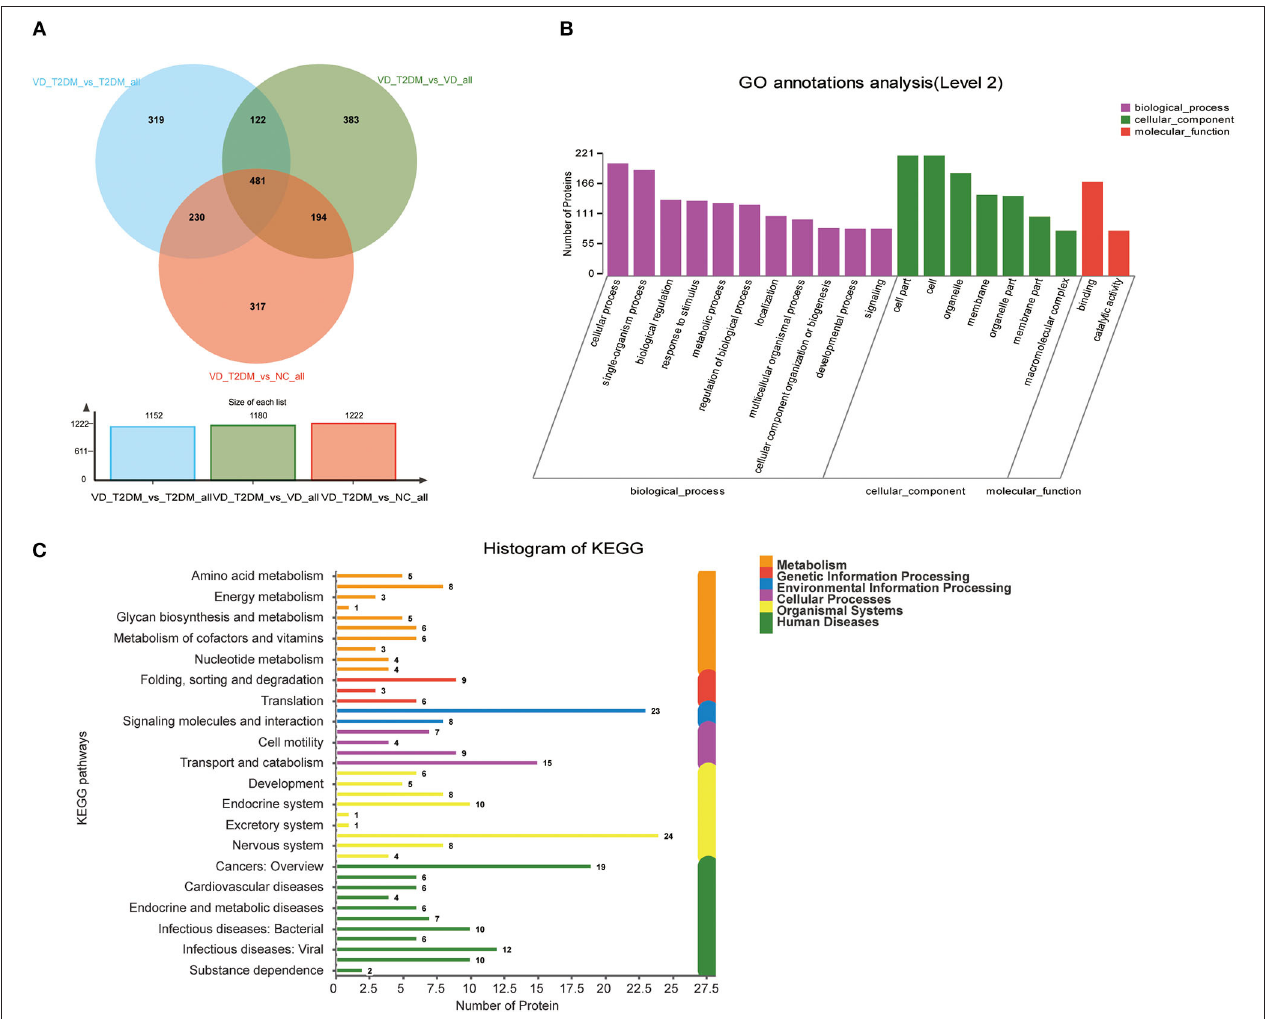
FIGURE 6 | Volcano plots of quantified proteins and functional analysis of DEPs in urine between the VD + T2DM group and the other three groups. (A) Venn chart of urine-based proteome analysis identified from the VD + T2DM group vs. the other three groups. (B) GO enrichment analysis of differential urine-excretory proteins. Purple bars denote the enriched biological processes, green bars denote enriched cellular components, and red bars denote enriched molecular functions. Protein numbers enriched in each category are presented with the bars. (C) The DEPs are associated with diseases and signal transduction pathways. The number of proteins associated with each category is